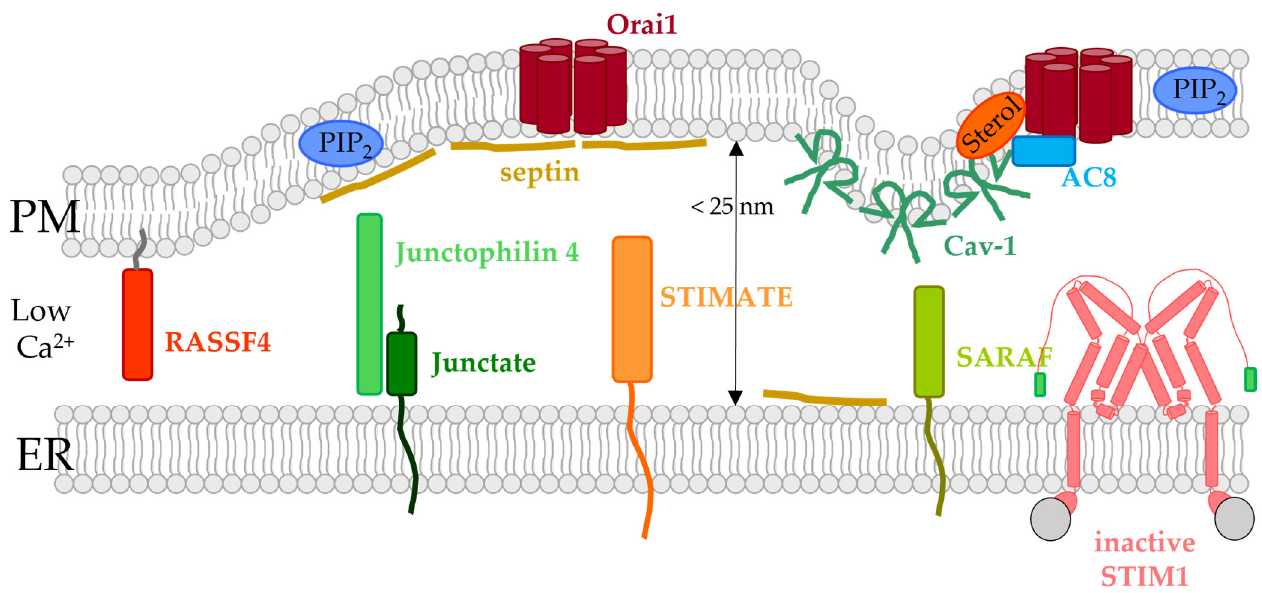
Figure 4. Modulatory proteins at the ER-PM contact sites involved in modulating the interplay of STIM1/Orai1. Schematic of all modulatory proteins located at the ER-PM contact sites reported to be critical for modulation of the STIM1/Orai1 complex. Junctate, junctophilin, STIMATE, and SARAF are located in the ER. RASSF4 and septins are located close to and Cav1 is anchored within the PM.